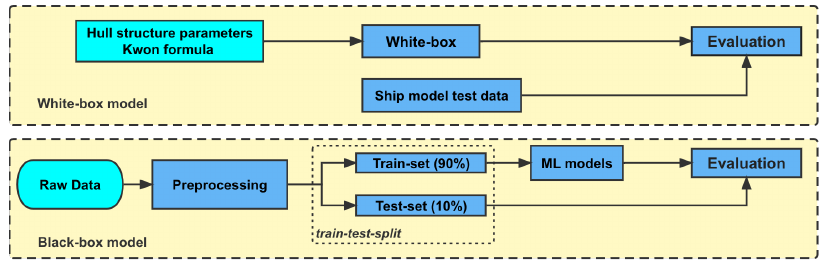
Figure 2. The flow charts of white- and black-box